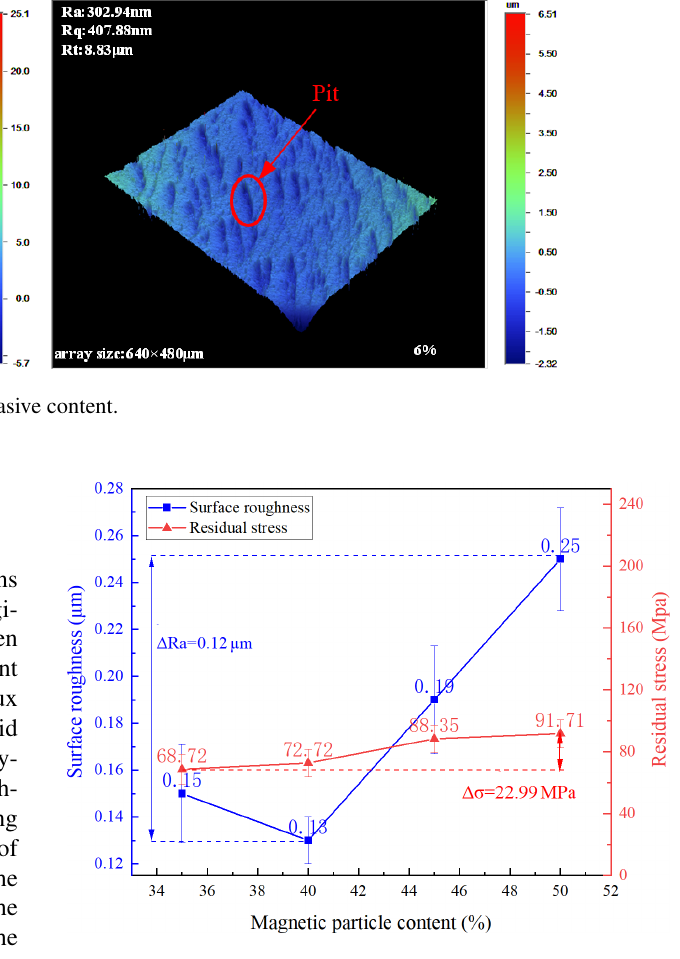
Figure 9. Effect of different magnetic particle abrasive content on surface roughness of the